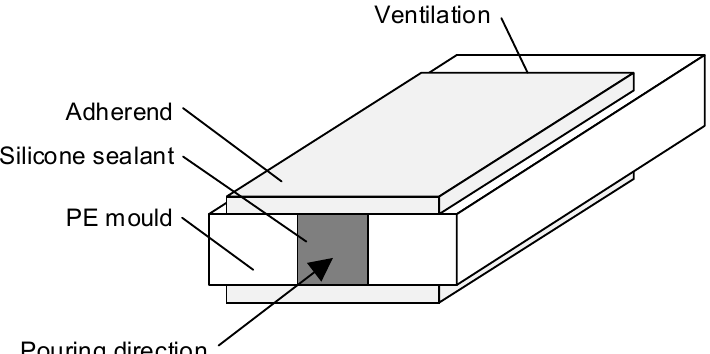
Fig. 8 Production of the specimen using a polyethylene